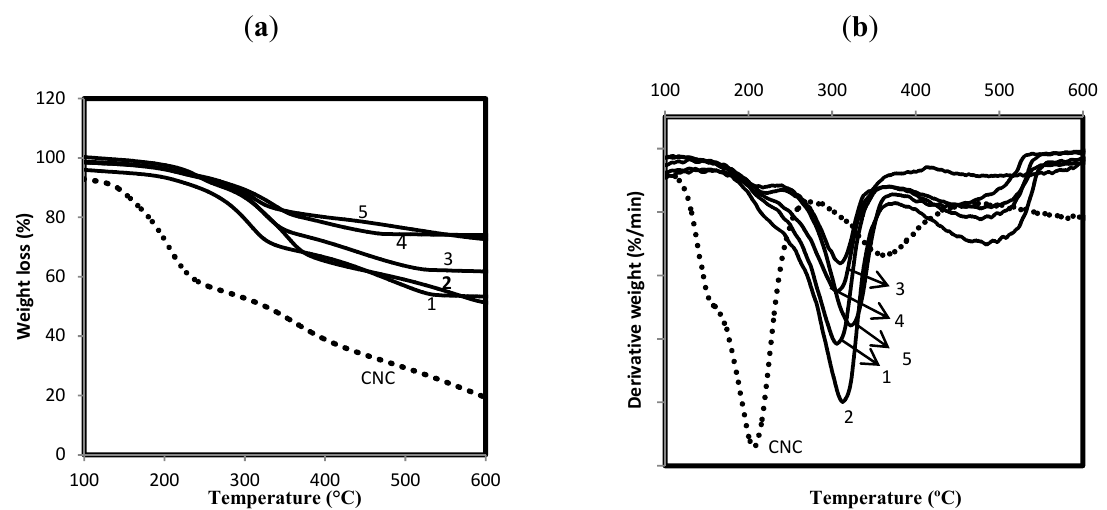
Figure 5. ( a ) TGA and ( b ) DTG thermograms of ZnO-Ag/CNCs and